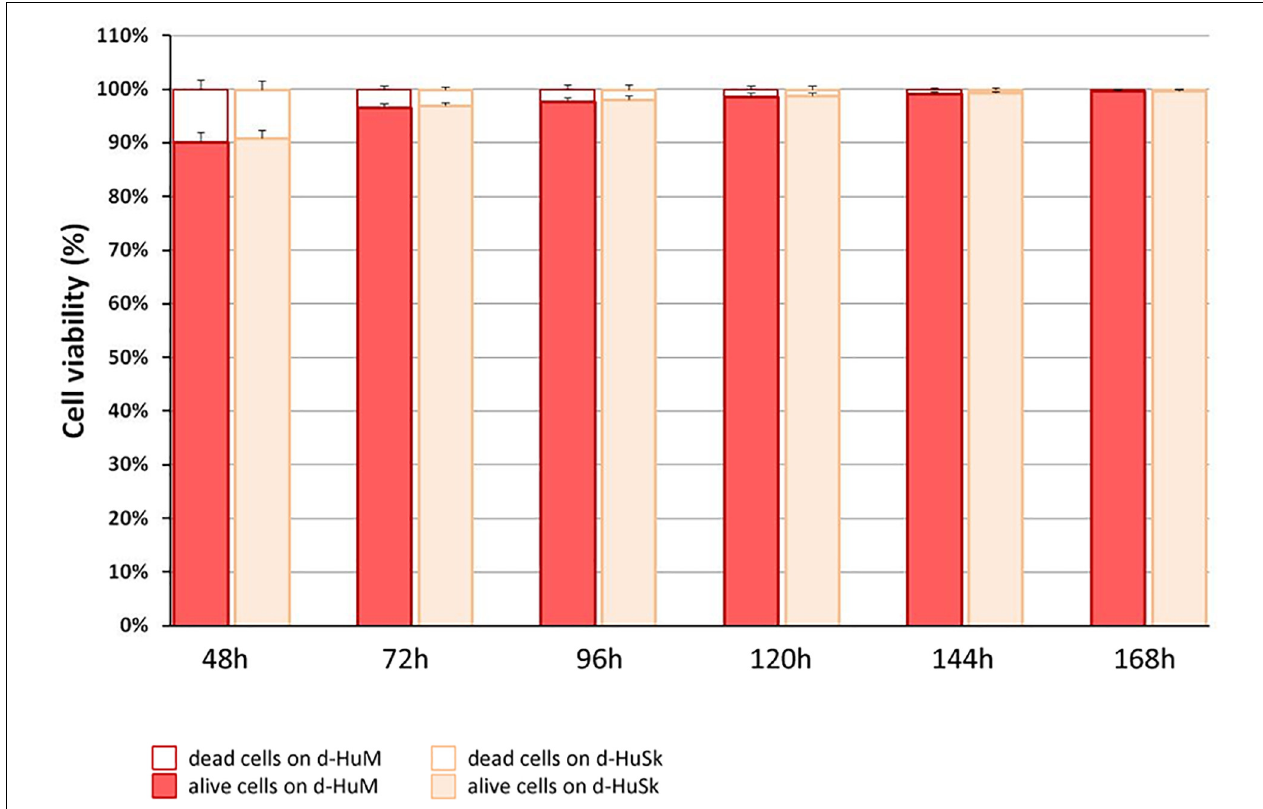
FIGURE 8 | Quantification of cell death rate and viability of hCPCs on d-HuM and d-HuSk. Mean death rate and mean viability of hCPCs cultured on d-HuSk or d-HuM, as measured by trypan blue exclusion assay. With time cell death rate dramatically decreased from around 9% to less than 1%, without any statistically significant differences between cells cultured on d-HuM or